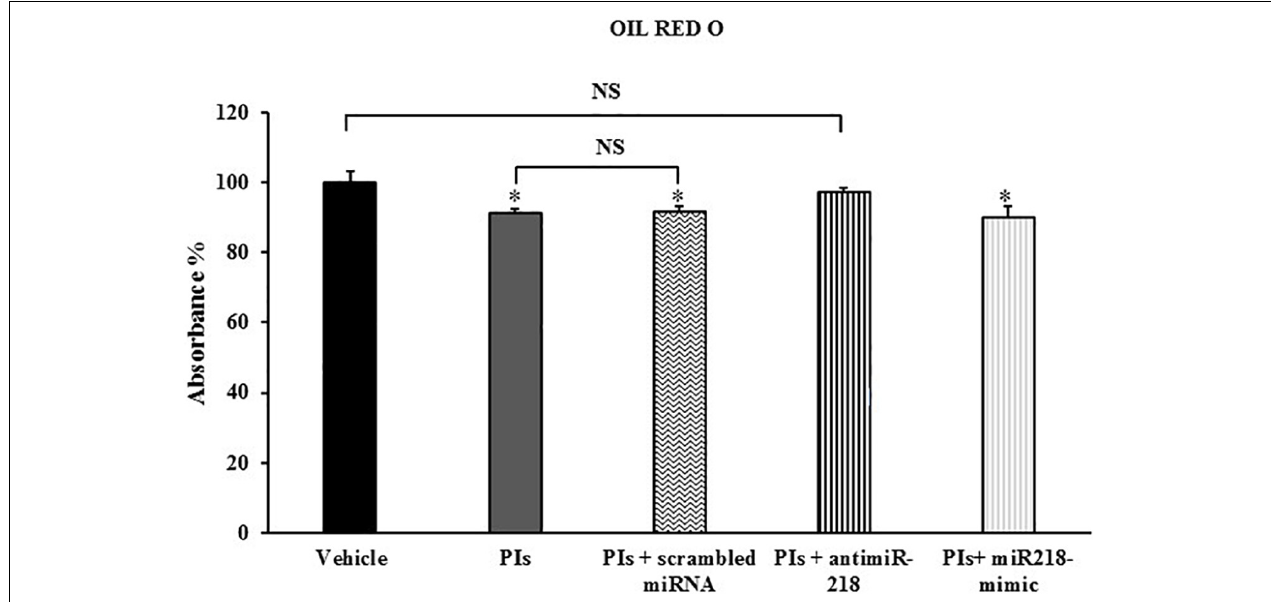
FIGURE 5 | Effects of loss and gain of function of miRNA-218 on lipid accumulation. Fully differentiated 3T3-L1 cells were treated with vehicle, or with PIs alone or in combination with scrambled miRNA or miRNA-218 inhibitor or miRNA-218 mimic. The intracellular lipids were stained with Oil Red O; the absorbance was measured at 520 nm and expressed as percent of control group. Results are the mean ± SEM of at least 18 determinations obtained in three independent experiments. ∗ p < 0.05 vs.